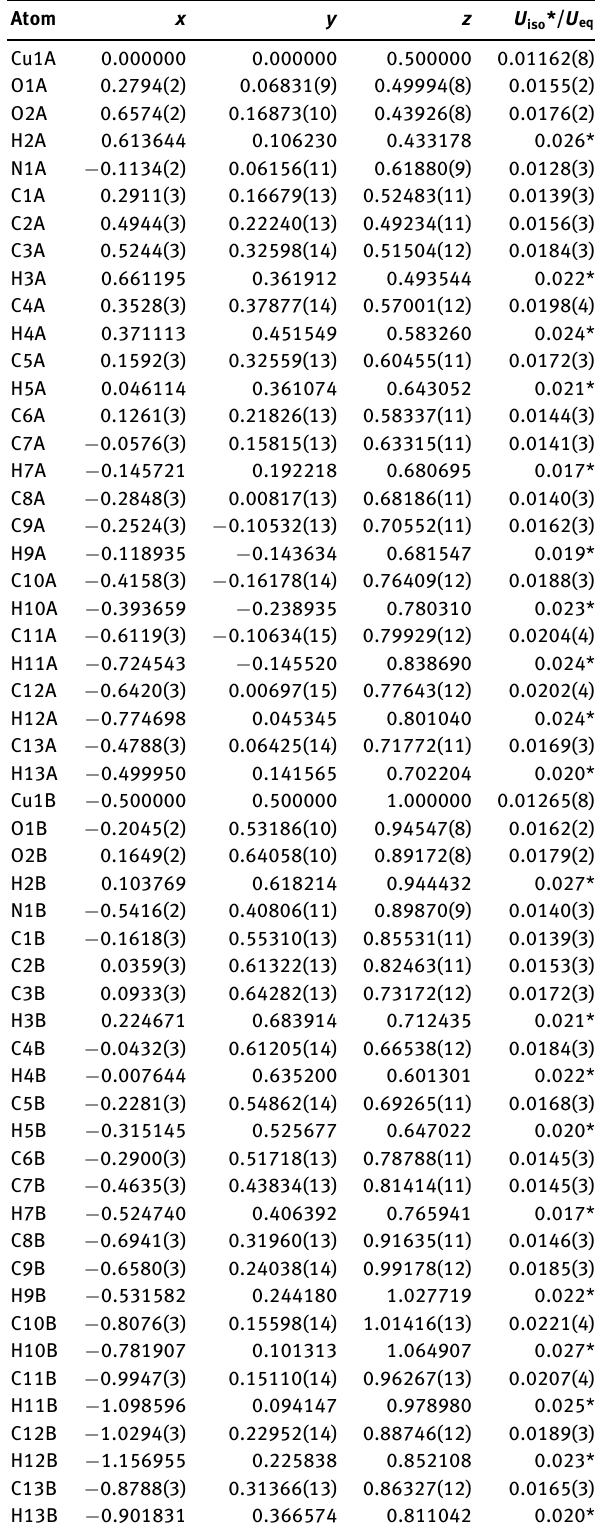
Table 2: Fractional atomic coordinates and isotropic or equivalent isotropic displacement parameters (Å 2